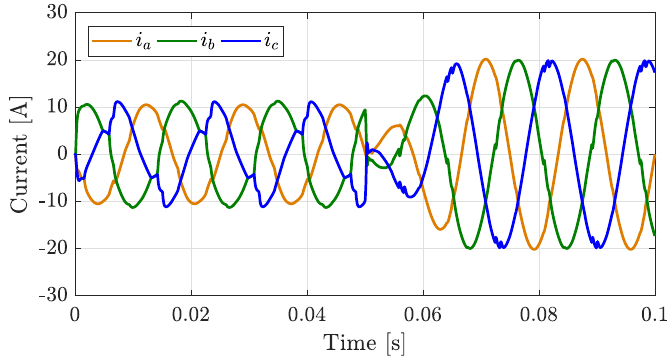
Figure 13. Compensation of PI controller driven by GA under balanced nonlinear conditions.